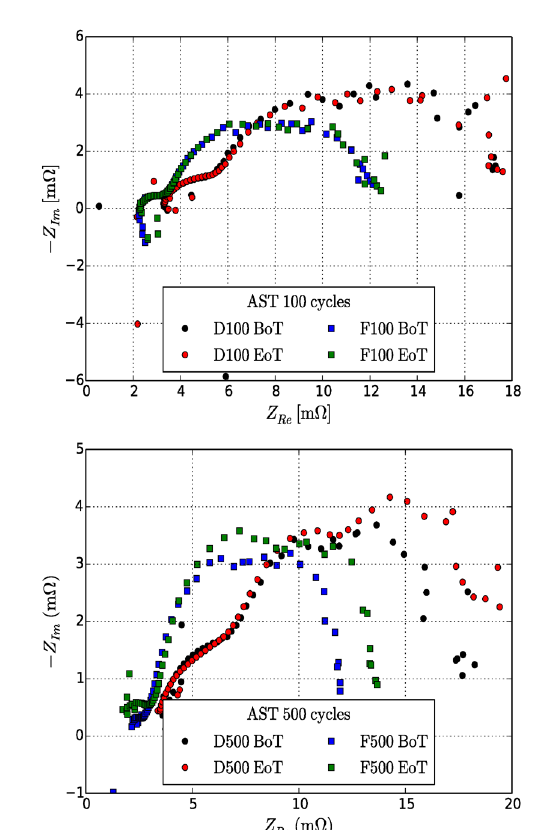
Fig. 3. Measured impedance spectra for all the MEA samples – the Nyquist plot.